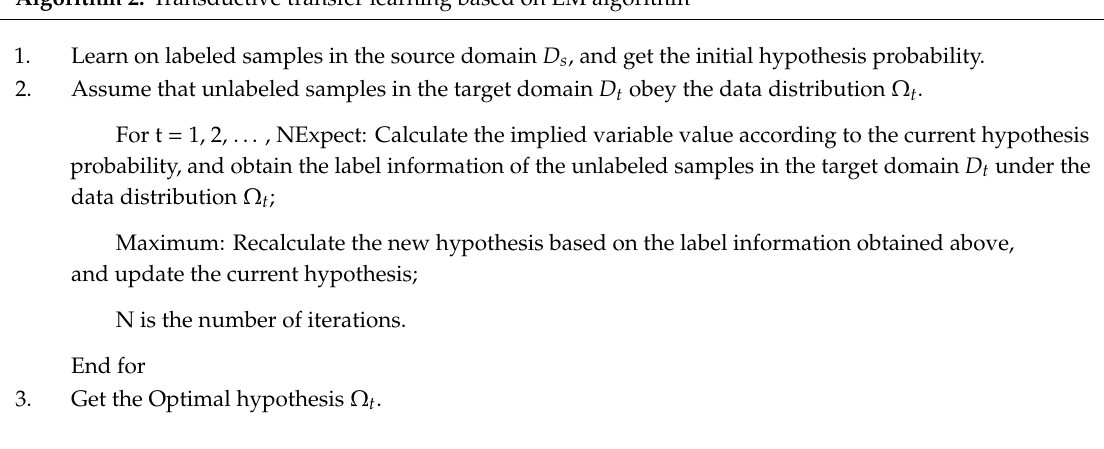
Algorithm 2. Transductive transfer learning based on EM